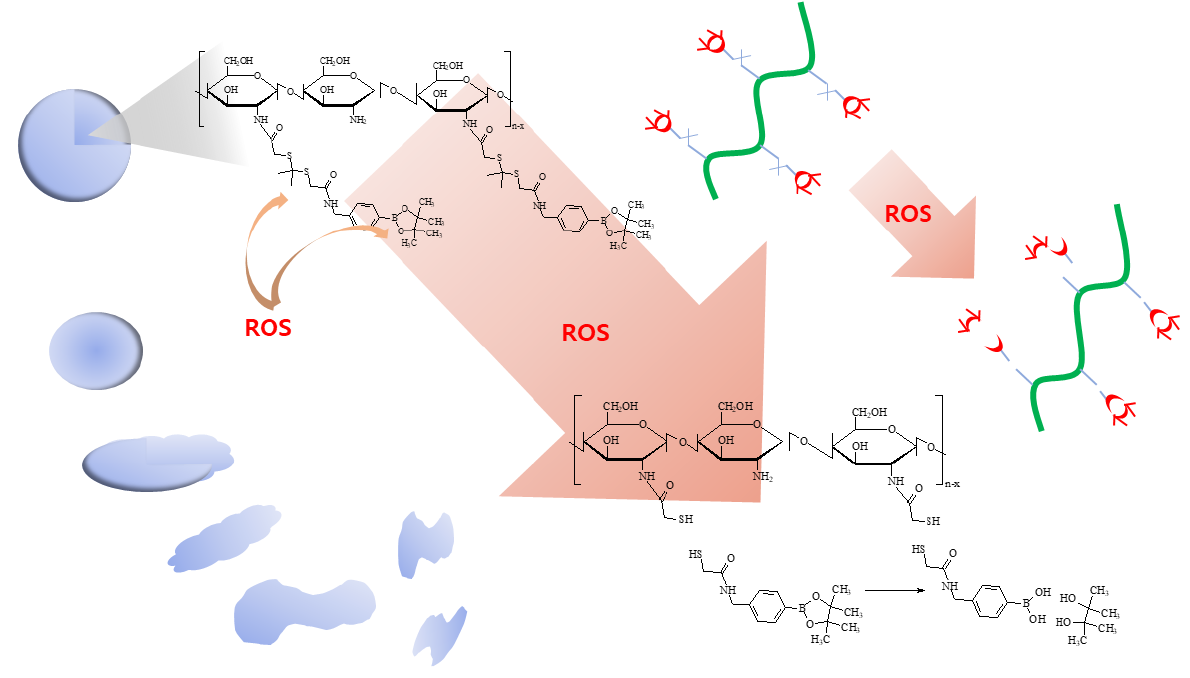
Figure 12. Schematic illustrations of Ce6-incorporated COSthPBAP